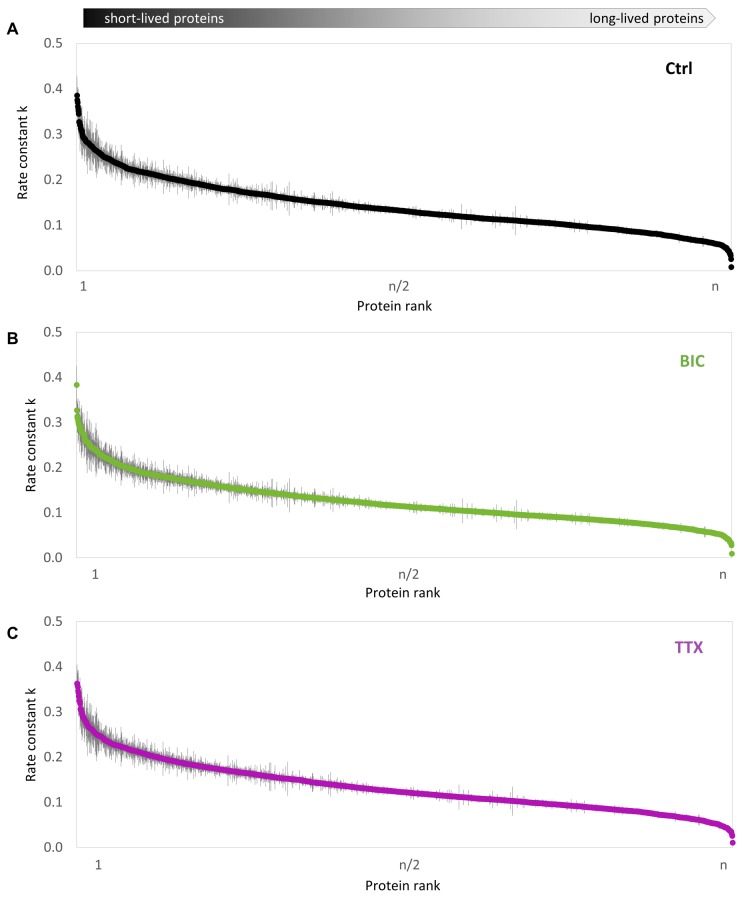
Precision of protein half-life determination.Protein half-lives were determined using a linear fit of the natural log transformed fraction of pre-existing proteins over time. Rate constants k (negative value of the slope of the fit) and the SE (standard error of the slope) are shown for each protein group for untreated (A), BIC-treated (B) and TTX-treated (C) cultures.